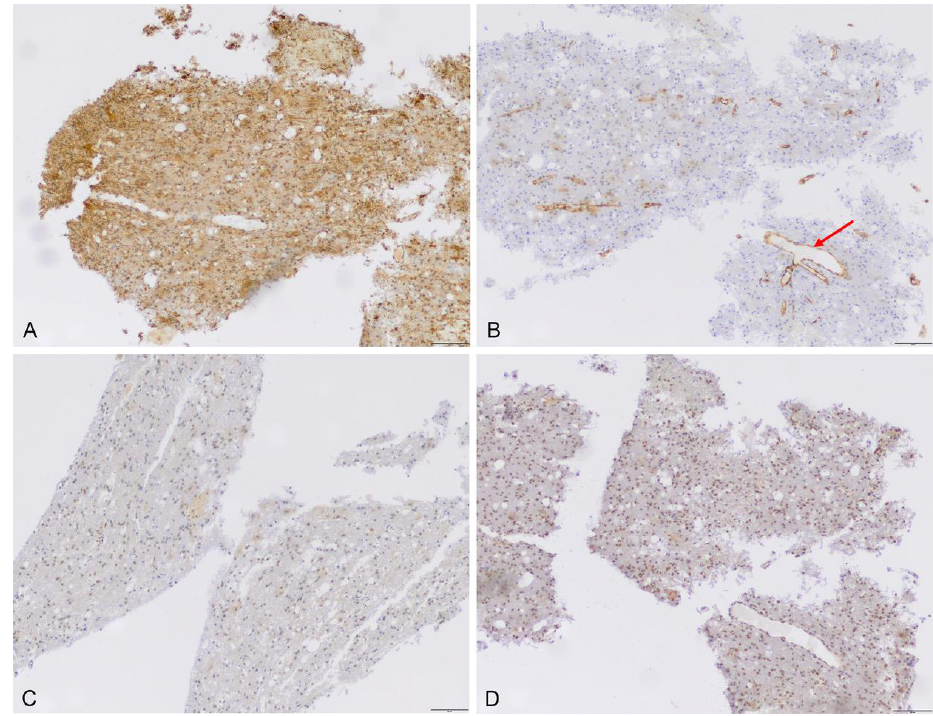
Figure 2. Illustrative samples of expression of the analyzed transporters and metabolism enzymes in the dura attachment of a meningioma, taken using immunohistochemistry. Expression of ABCB6 ( A ), ABCG2 ( B ), FECH ( C ) and CPOX ( D ) was found in tumor tissue (arrows) but not in the adjacent dura mater (*, scale bar 100 µm, magnification 10-fold).